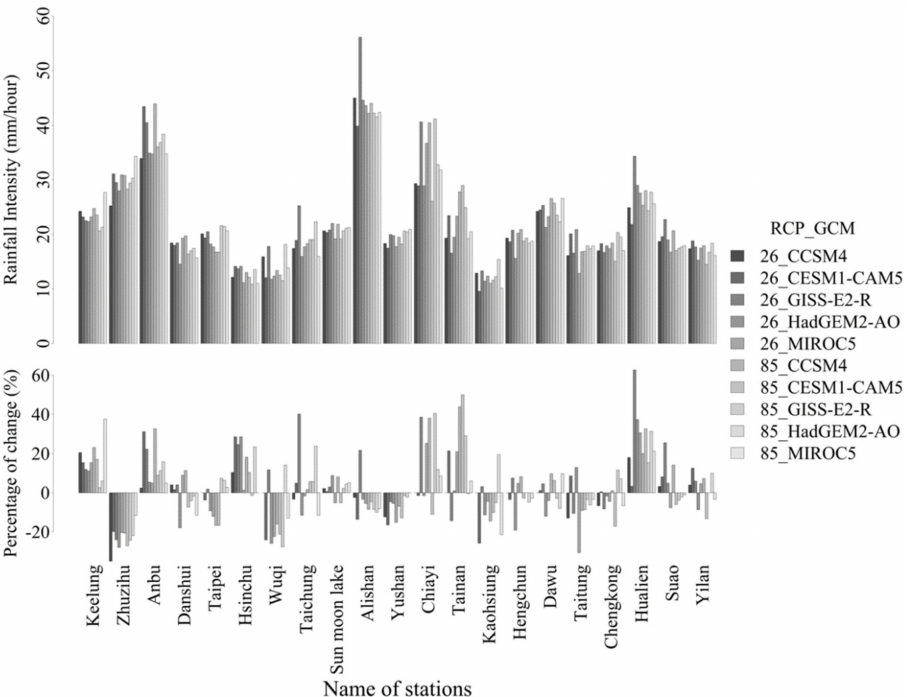
Figure 7. Rainfall intensities ( top ) and percentage changes ( bottom ) of events with 24-h duration and 25-yr return period (events long ) for the near future (2021–2040) under RCP 2.6 and RCP 8.5 for five GCMs (CCSM4, CESM1-CAM5, GISS-E2-R, HadGEM2-AO, MIROC5).